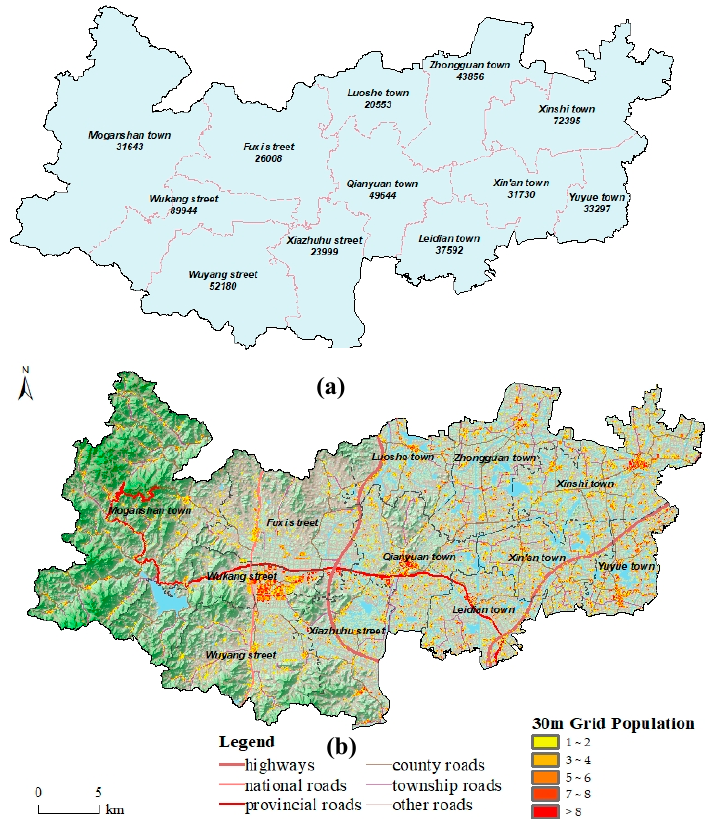
Figure 3. Geospatial disaggregation of population census data. ( a ) Administrative unit-based population data; ( b ) 30-m population density with topographic